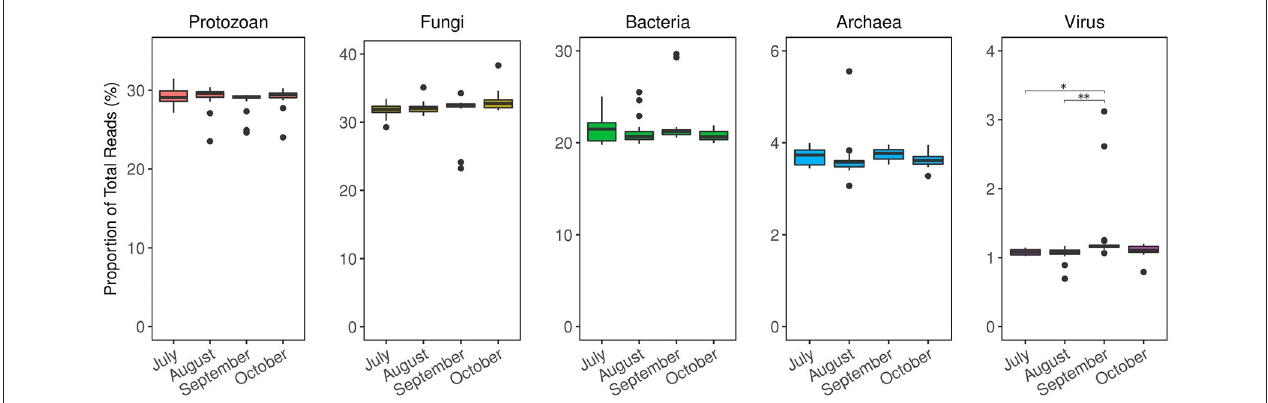
FIGURE 5 | Taxonomic distribution of Siderastrea siderea coral microbiomes from metagenome analysis over time. Results are normalized as the relative abundance of each taxa at every time point. The microbiome composition among domains remained relatively stable throughout time, except for viral annotations. The relative abundance of viral annotations was higher in September, compared to July ( p = 0.01) and August ( p < 0.01). * p ≤ 0.05; ** p ≤ 0.01.